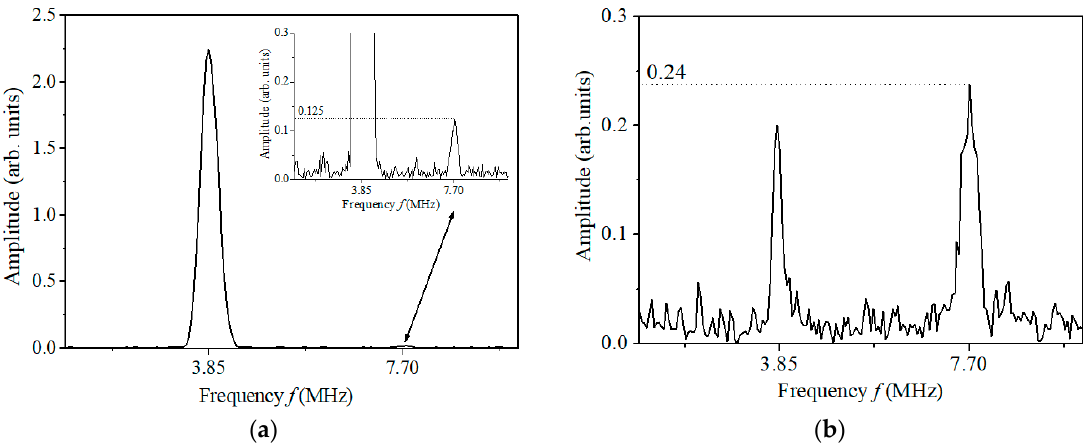
Figure 9. The amplitude-frequency curves measured by the conventional approach ( a ) and the phase-reversal approach ( b ).